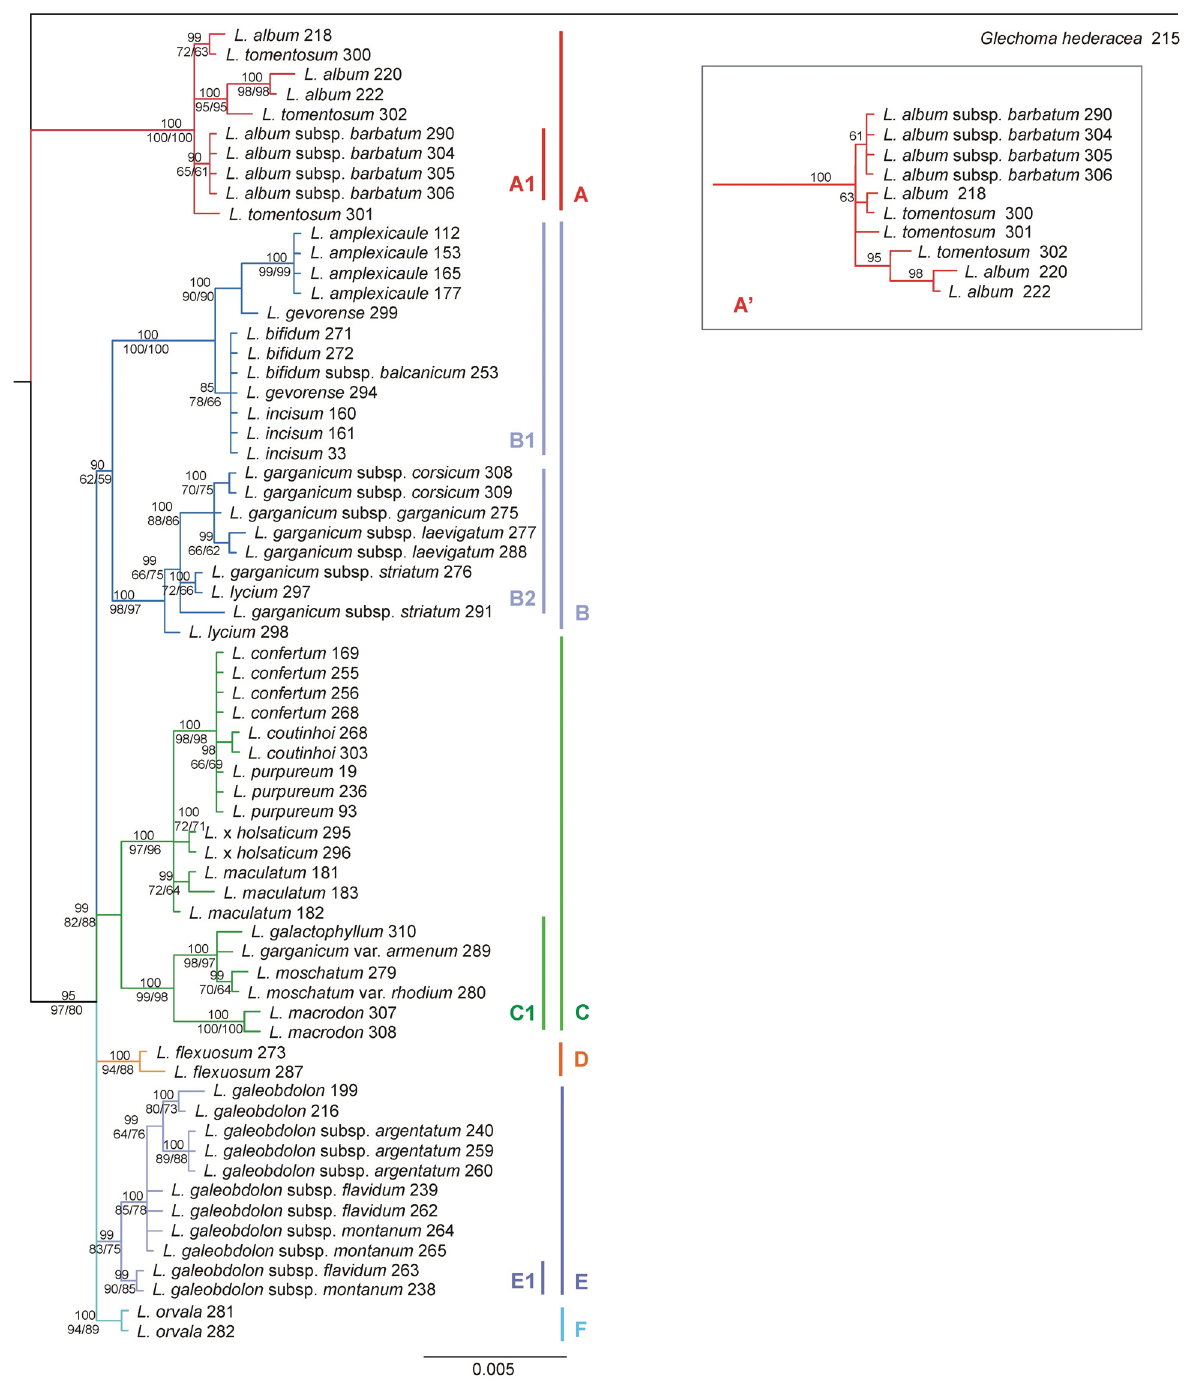
Figure 5. The 50% majority-rule consensus phylogram derived from a Bayesian analysis of rpo genes ( rpoA , rpoB , rpoC1 , rpoC2 ). Credibility values above 0.50 are given in the top line. Bootstrap values of clades supported by maximum parsimony and maximum likelihood analysis are given below (MP value before the slash and ML after the slash). Clades discussed in the text and in Table 2 are marked with a letter. Topography of the clade A obtained with ML method supplied with ML values is shown in a frame as a clade